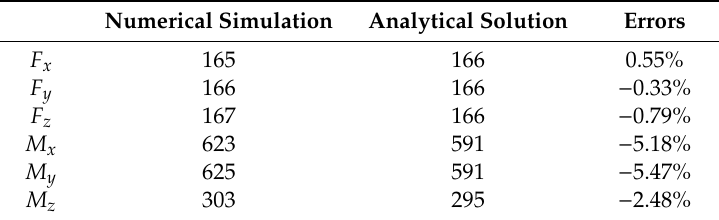
Table 5. Comparison of strain on elastic beam between numerical simulation and analytical solution in the optimized structure.